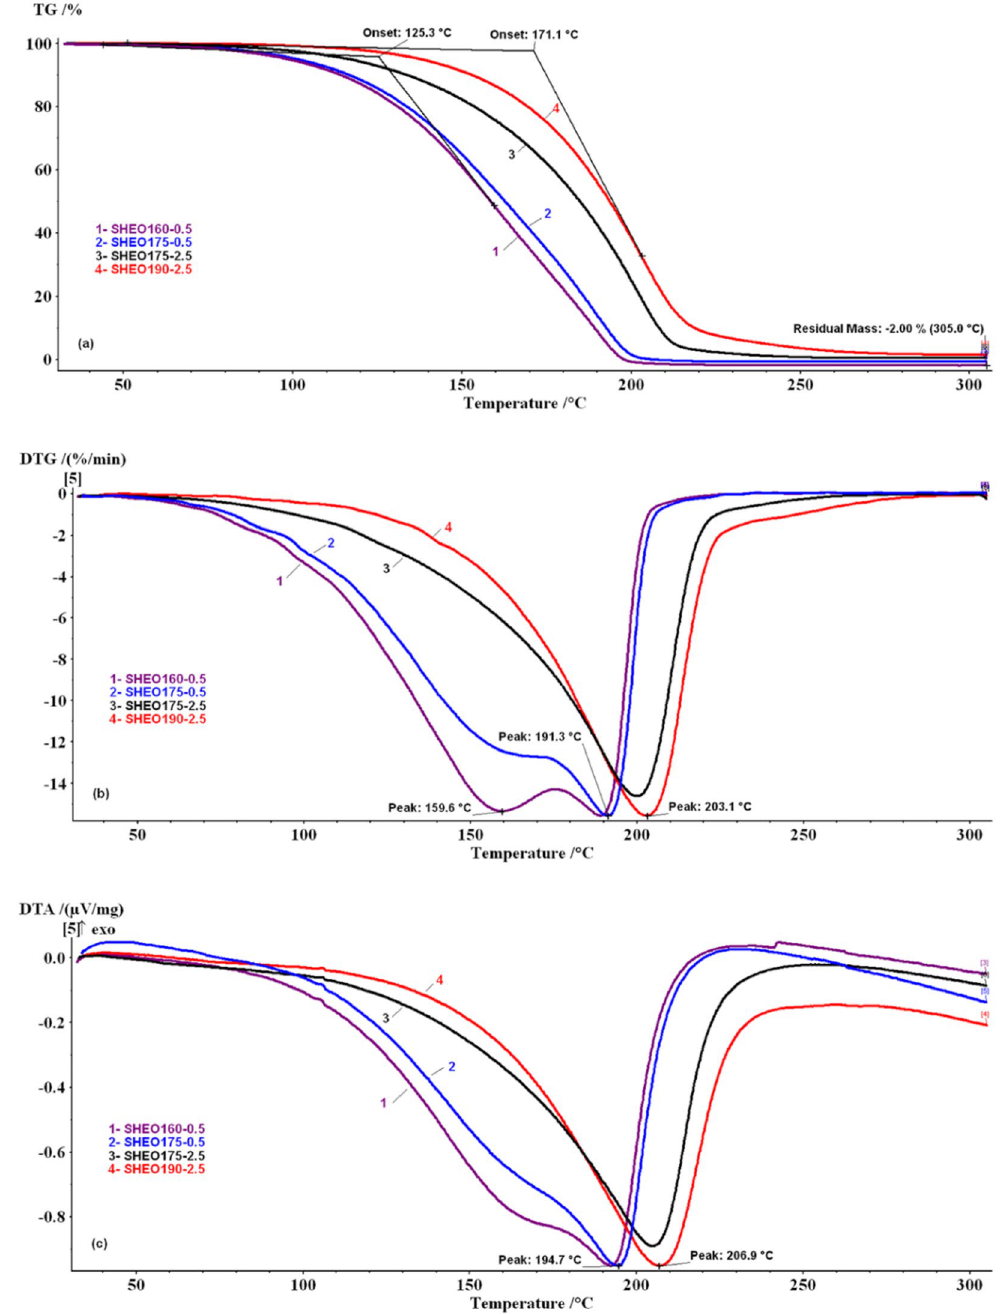
Figure 5. Thermo-analytical curves of SHEOx-y samples in the nitrogen decomposition atmosphere. (a) TG curves; (b) DTG curves; (c) DTA